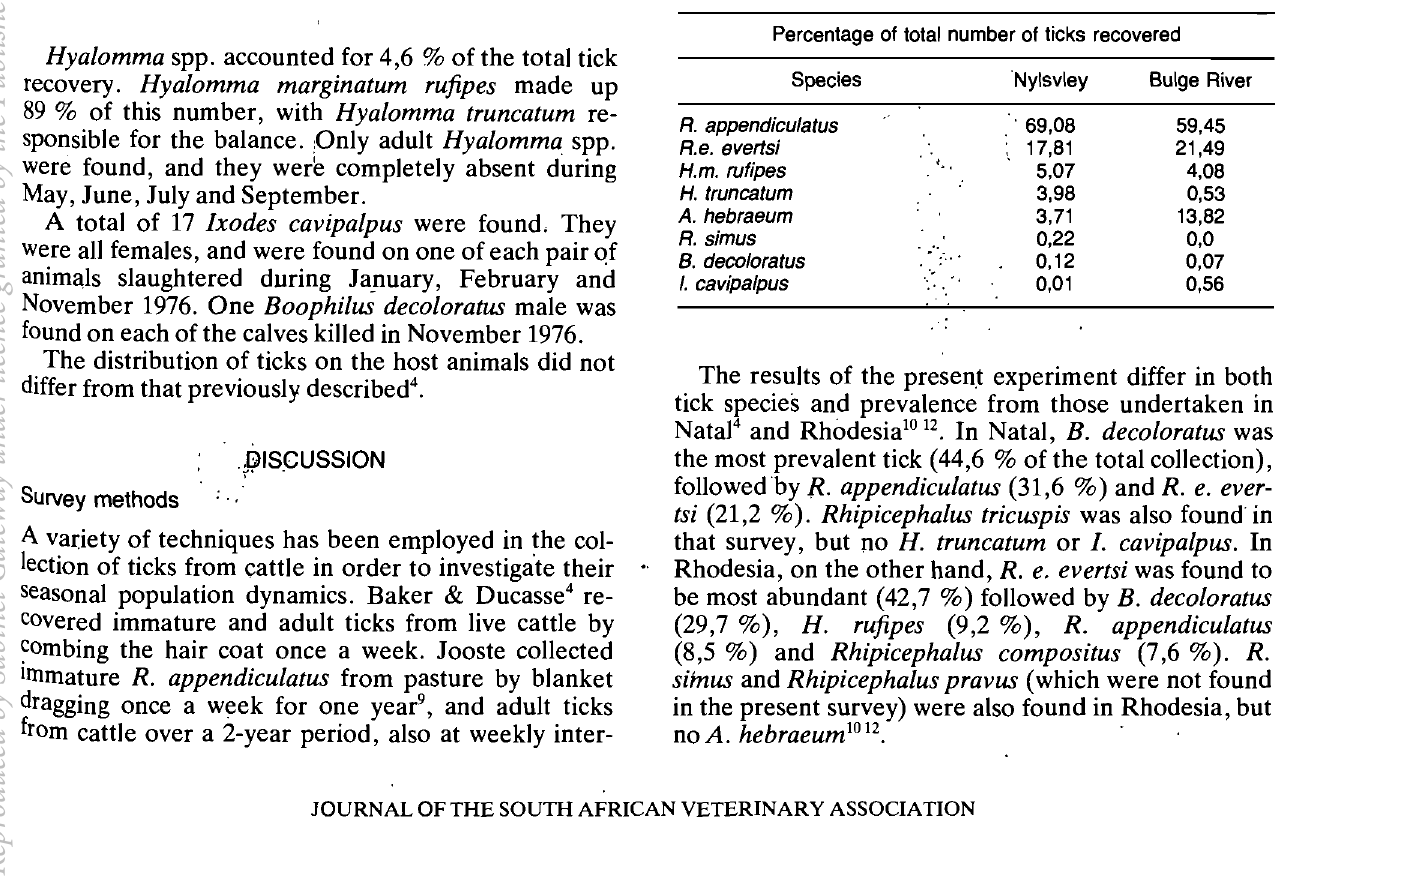
Table 2: COMPARATIVE TICK POPULATION COMPOSITIONS AT NYLSVLEY AND BULGE RIVER Percentage of total number of ticks